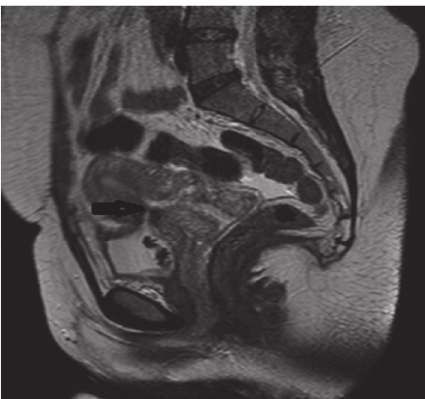
Figure 3: Operation image of the fistula tract in the uterus subsegment and bladder posterior wall.